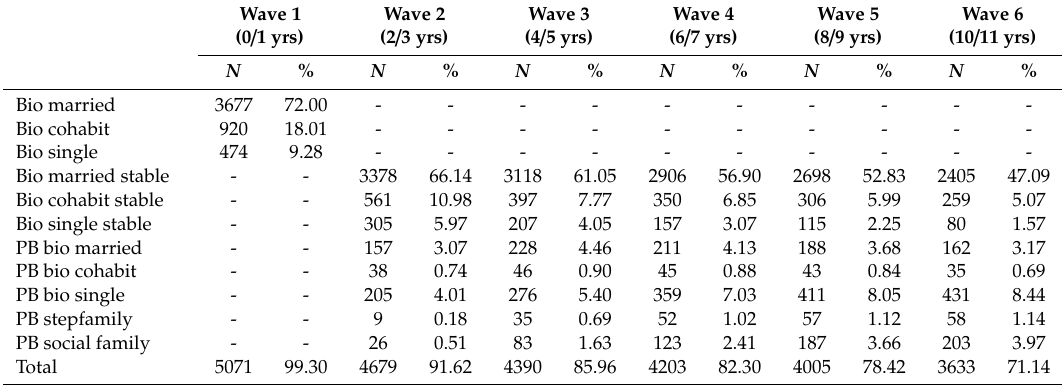
Table 1. Australian family structures over six waves.